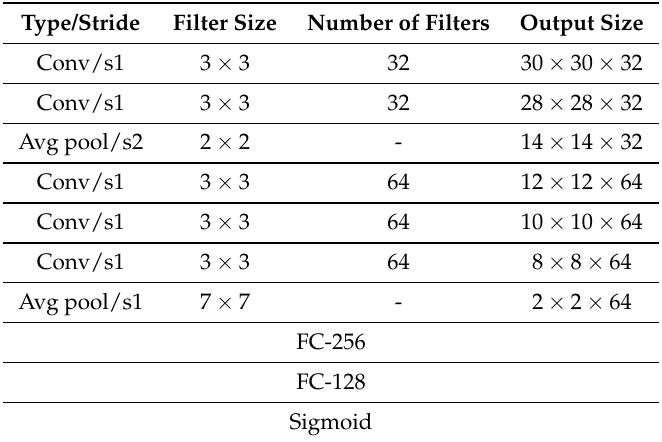
Table 1. The CNN architecture for kernel classification. The Conv, FC, and Avg pool stand for convolutional layer, fully connected layer, and average pooling layer,